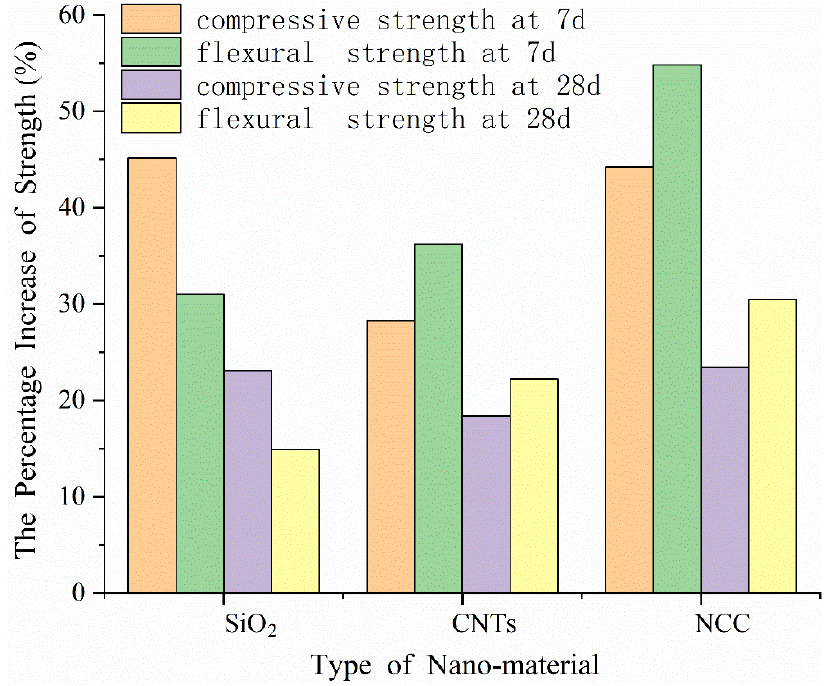
Figure 3. The percentage increases of the three nanomaterials at 7 d and 28 d.